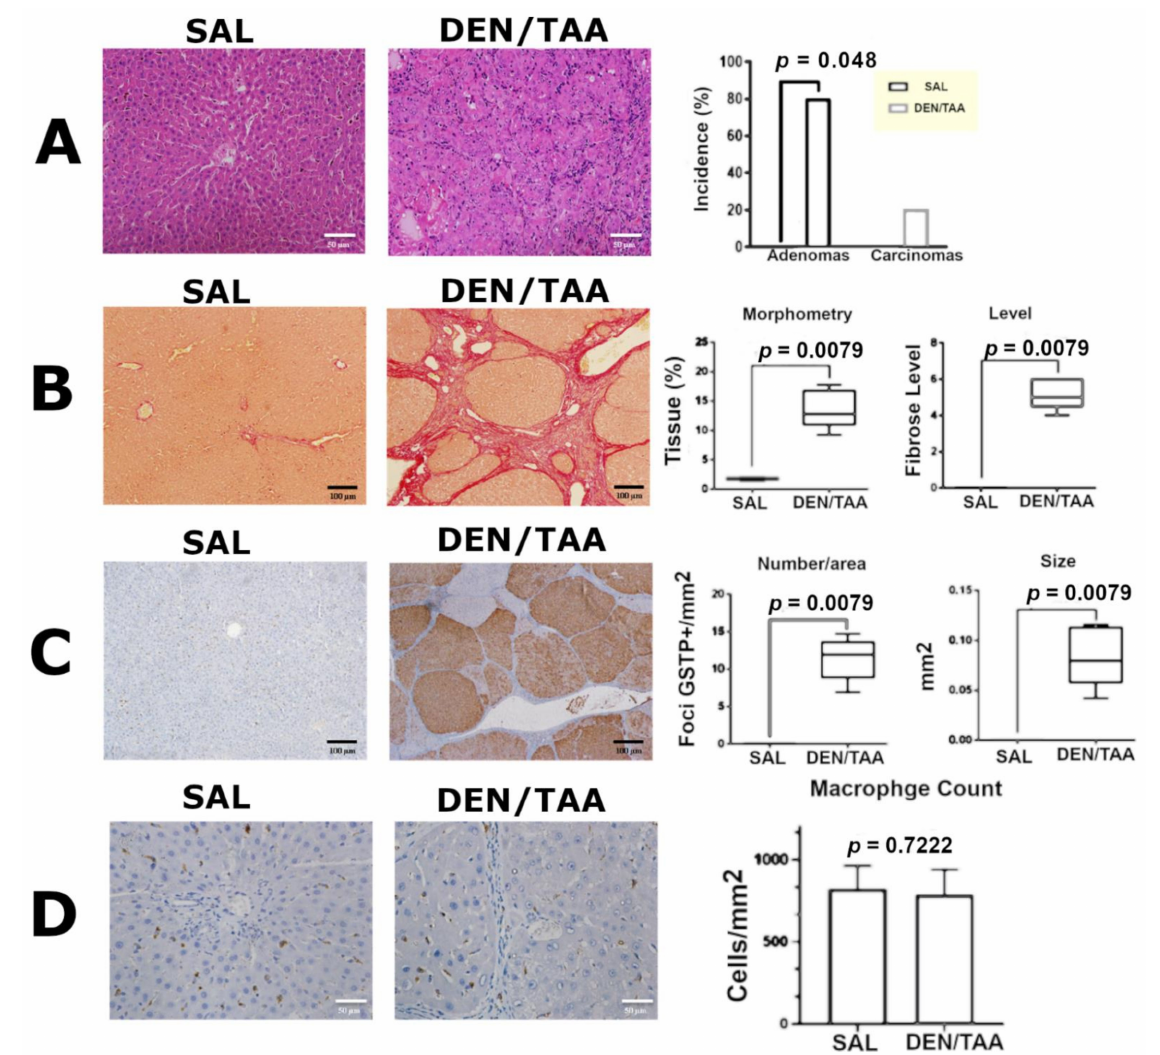
Figure 3. ( A ) Representative images of H&E-stained sections of SAL (left) and DEN/TAA (center) livers; HCC was characterized by profound cellular atypia and was composed of malignant hepa- tocytes arranged in acinar structures in the DEN/TAA group. Data on the incidence of adenomas and carcinomas are presented in terms of proportion (%) of affected animals and were analyzed by Fisher’s exact test ( p < 0.05) (right). ( B ) Collagen analysis shown with picro-Sirius red, showing sections from the SAL (left) and DEN/TAA (center) groups. Morphometry and degree of fibrosis data are presented in box plots and were analyzed using the Mann–Whitney test ( p < 0.05) (right). ( C ) Immunohistochemistry sections from the SAL group (left) and the multiple GST-P+ nodules in the DEN/TAA group (center). The number and size of GST-P+ lesions are presented in box plots and were analyzed using the Mann–Whitney test ( p < 0.05) (right). ( D ) Immunohistochemistry for the CD68 marker in sections from the SAL (left) and DEN/TAA (center) groups, showing macrophages. Macrophage count data are presented as means and standard deviations and were analyzed using a t -test ( p < 0.05)